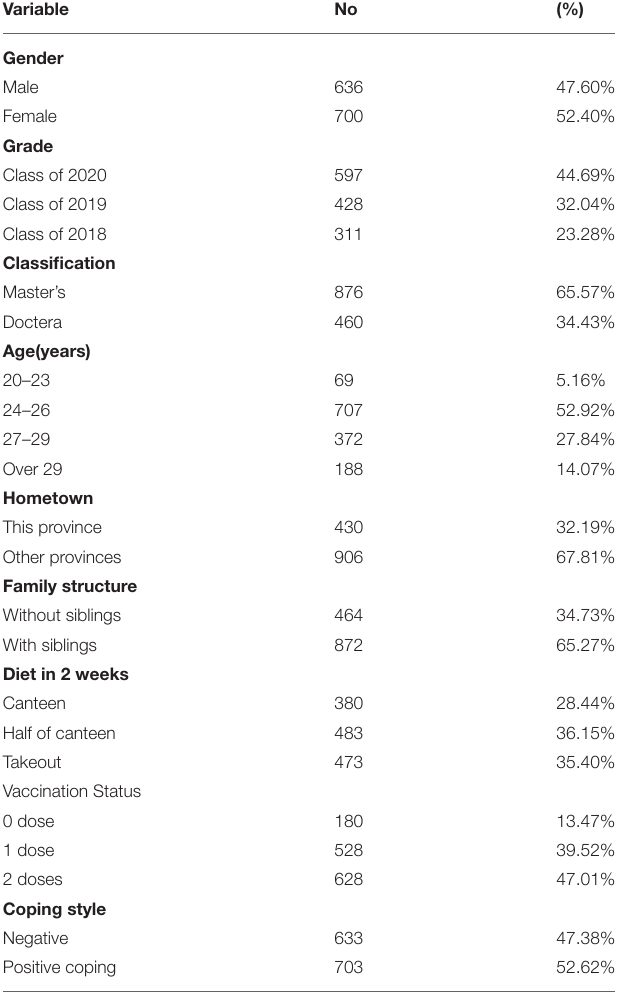
TABLE 1 | Demographic characteristics of study sample ( N =